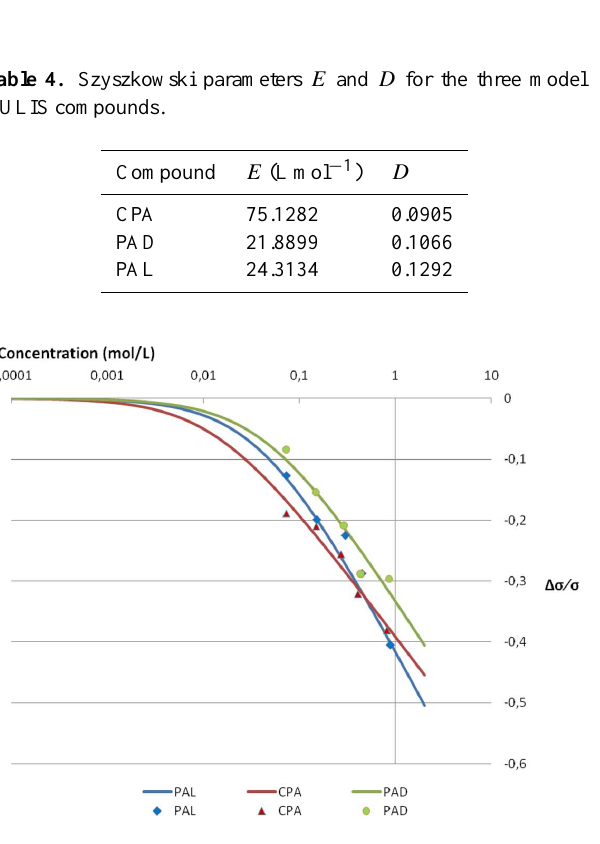
Fig. 6. Szyszkowski graph – comparison between the three model HULIS compounds.